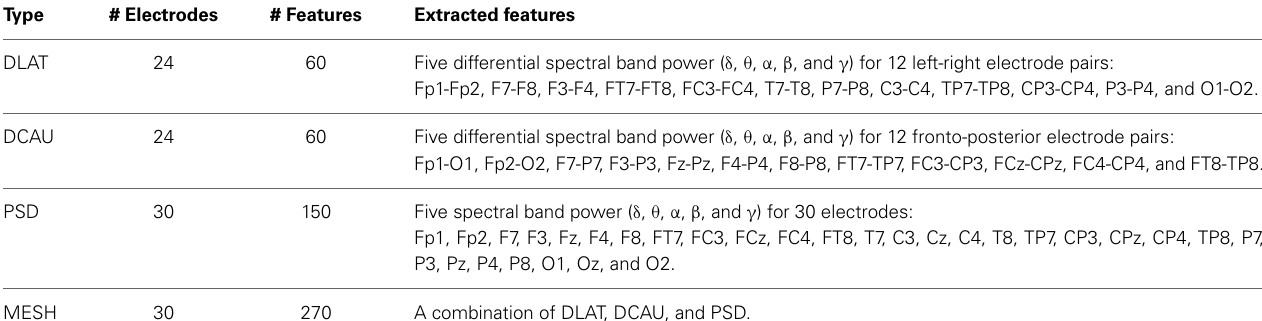
Table 1 | A summary of EEG feature